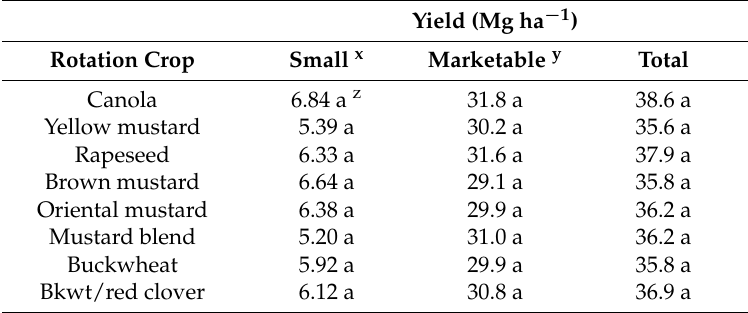
Table 6. Average potato tuber yield of marketable, small (cull), and total tuber yield as affected by previous rotation crop treatments at the Northern Aroostook site in potato Year